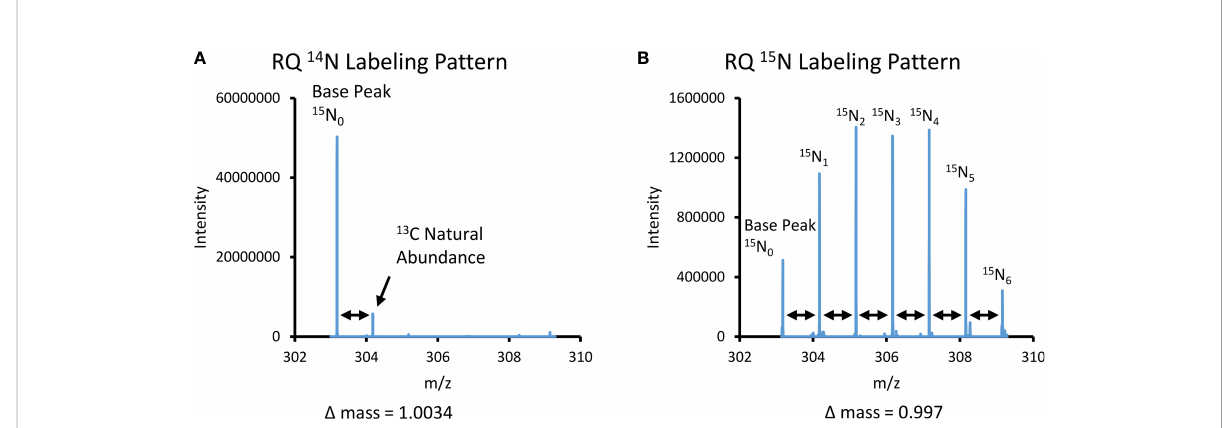
FIGURE 2 Spectra comparison of non-labeled 14 N and labeled 15 N arginine-glutamine dipeptide. (A) Mass spectral pattern for the dipeptide arginine- glutamine (RQ C 11 H 22 N 6 O 4 ) under 14 N conditions. There is a base peak in the spectrum that corresponds to the mass of the RQ dipeptide under positive ionization polarity, m/z = 303.177. A secondary minor peak in the spectra that corresponds to the 13 C natural abundance peak, as determined by the D mass = 1.0034 to the base peak. (B) Mass spectral pattern for the dipeptide arginine-glutamine (RQ) under stable isotope 15 N NH 4 Cl incubated conditions. There is a base peak in the spectra that corresponds to the mass of the RQ dipeptide under positive ionization polarity, m/z = 303.177. There are six successive peaks in the spectra caused by the mass shifts due to each successive nitrogen atom, as determined by the D mass = 0.997 to the base peak and each successive